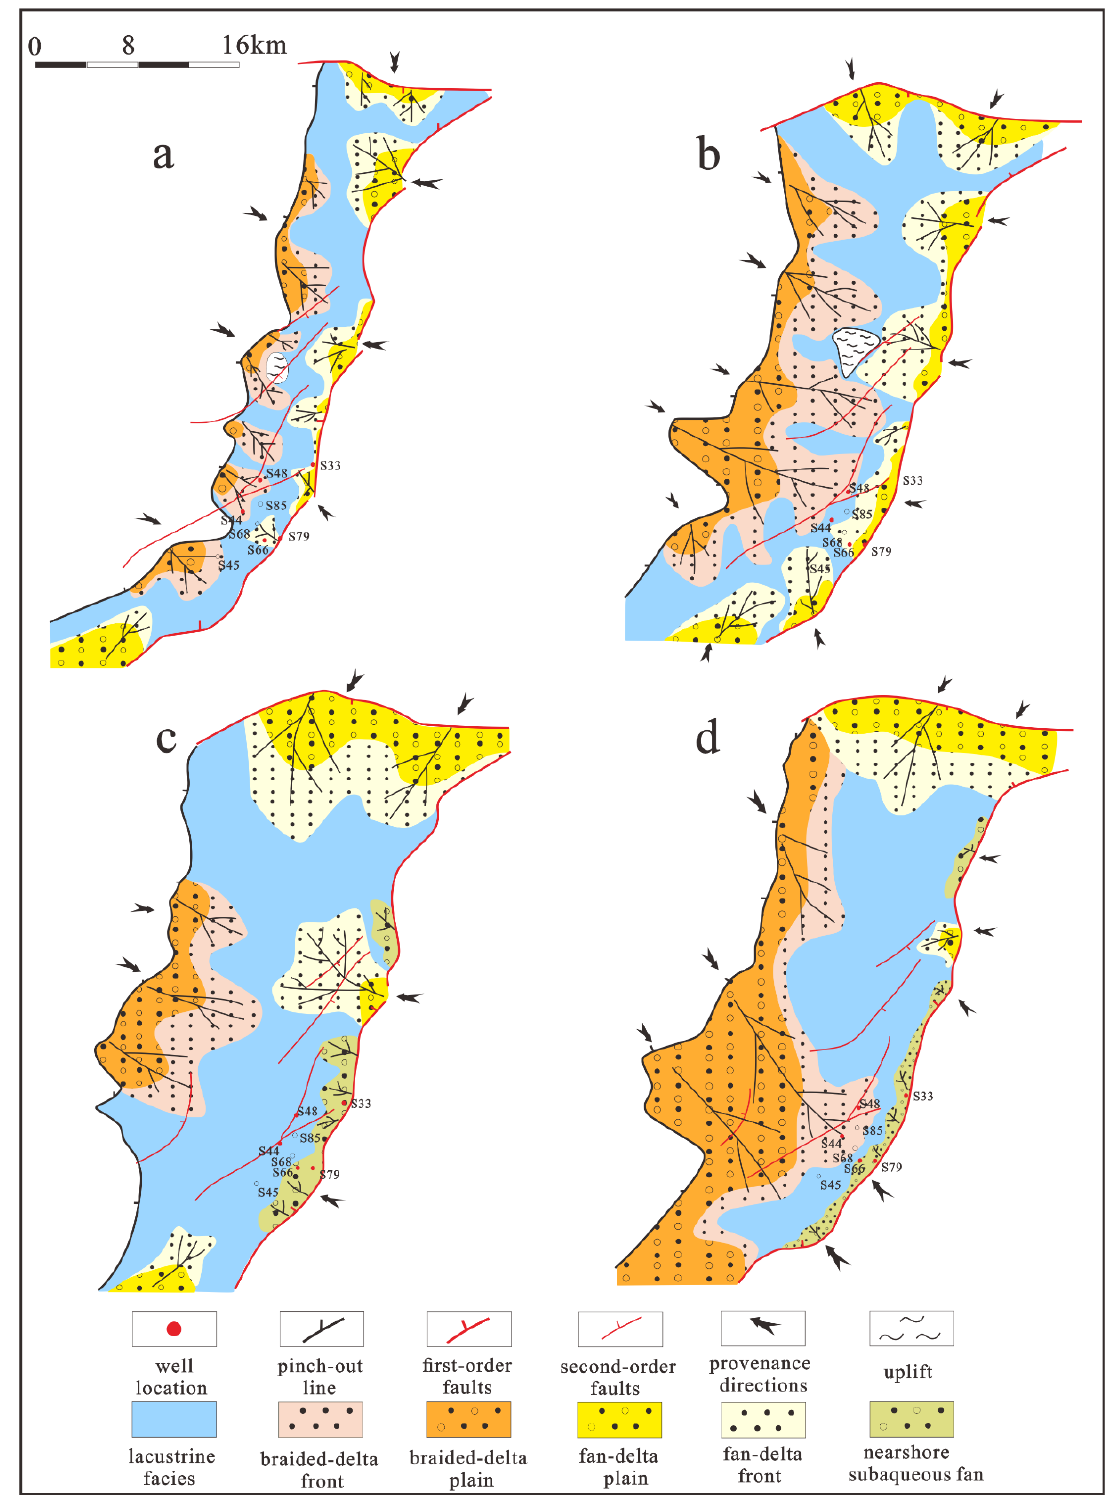
Figure 12. Planar distribution of depositional systems in the Lower Cretaceous Saihantala sag [62,63] indicating sedimentary facies evolution of the sag. ( a ) Planar distribution of depositional systems in the Saihantala sag during the depositing period of LK 1 ba. ( b ) Planar distribution of depositional systems in the Saihantala sag during the depositing period of UK 1 ba. ( c ) Planar distribution of depo- sitional systems in the Saihantala sag during the depositing period of K 1 bt 1 . ( d ) Planar distribution of depositional systems in the Saihantala sag during the depositing period of K 1 bt 2